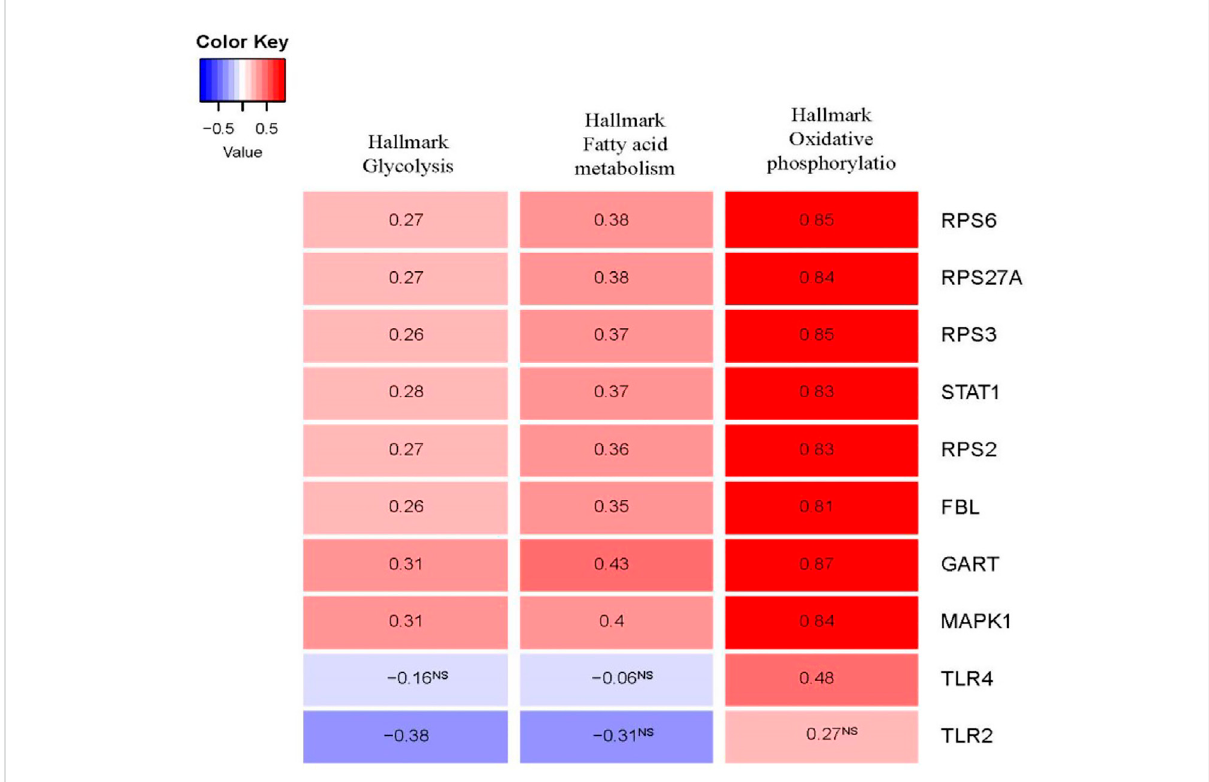
FIGURE 8 The expression levels of hub genes are signi fi cantly correlated with ssGSEA scores of hallmark glycolysis, hallmark fatty acid metabolism, and hallmark oxidative phosphorylation genesetinPAH(Spearman ’ scorrelation test, p < 0.05).The hallmark genesets weredownloaded from theGSEA